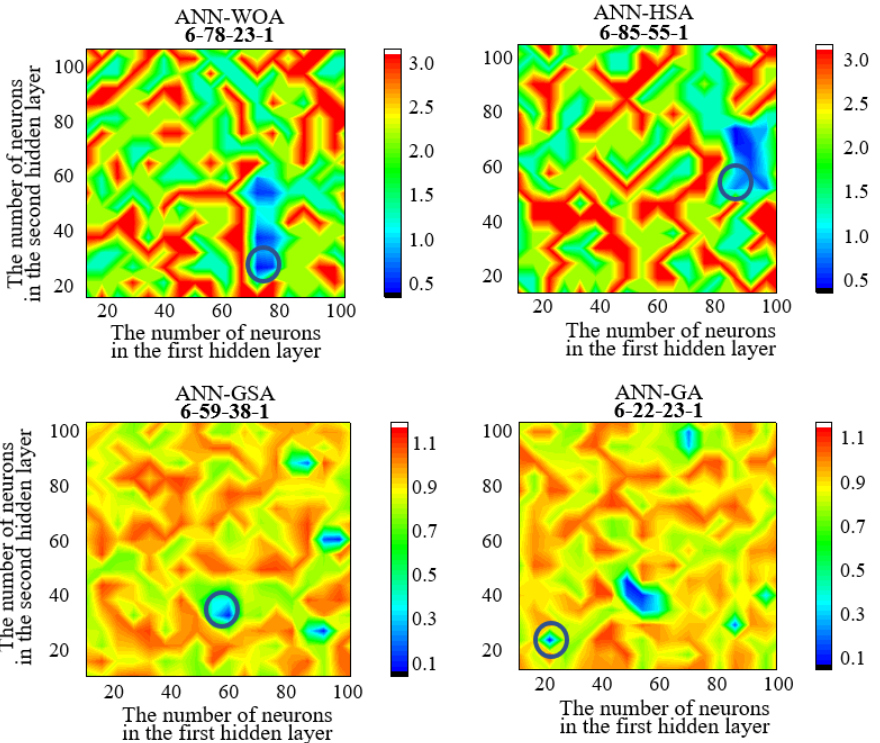
Figure 24. RMSE distributions of the predictions using ANN-WOA, ANN-HAS, ANN-GSA, and ANN-GA models with different numbers of hidden layers and neurons.